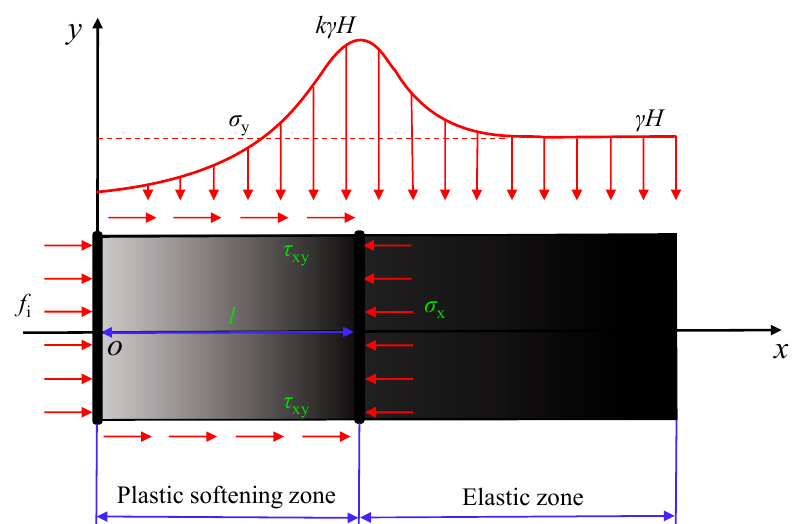
Figure 18. The mechanical model of solid coal rib [54].